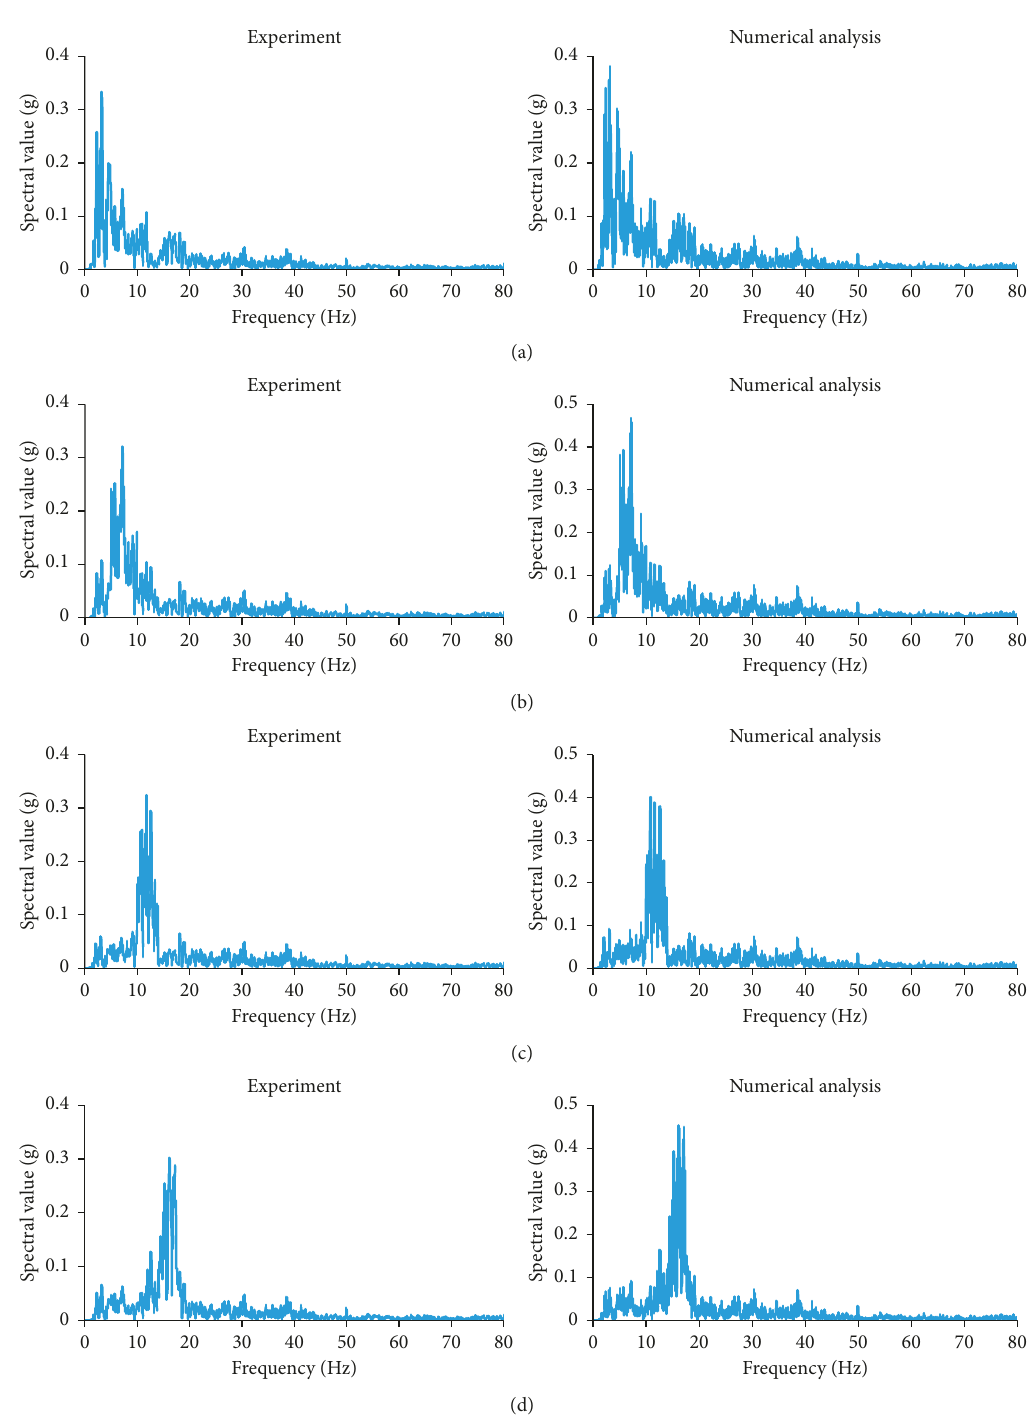
Figure 8: Fourier acceleration amplitude spectrum at point A7 under the Castaic wave (0.2g). (a) Natural slope without vegetation. (b) Hinged block slope. (c) Hinged block ecological slope. (d) Anchor + hinged block ecological